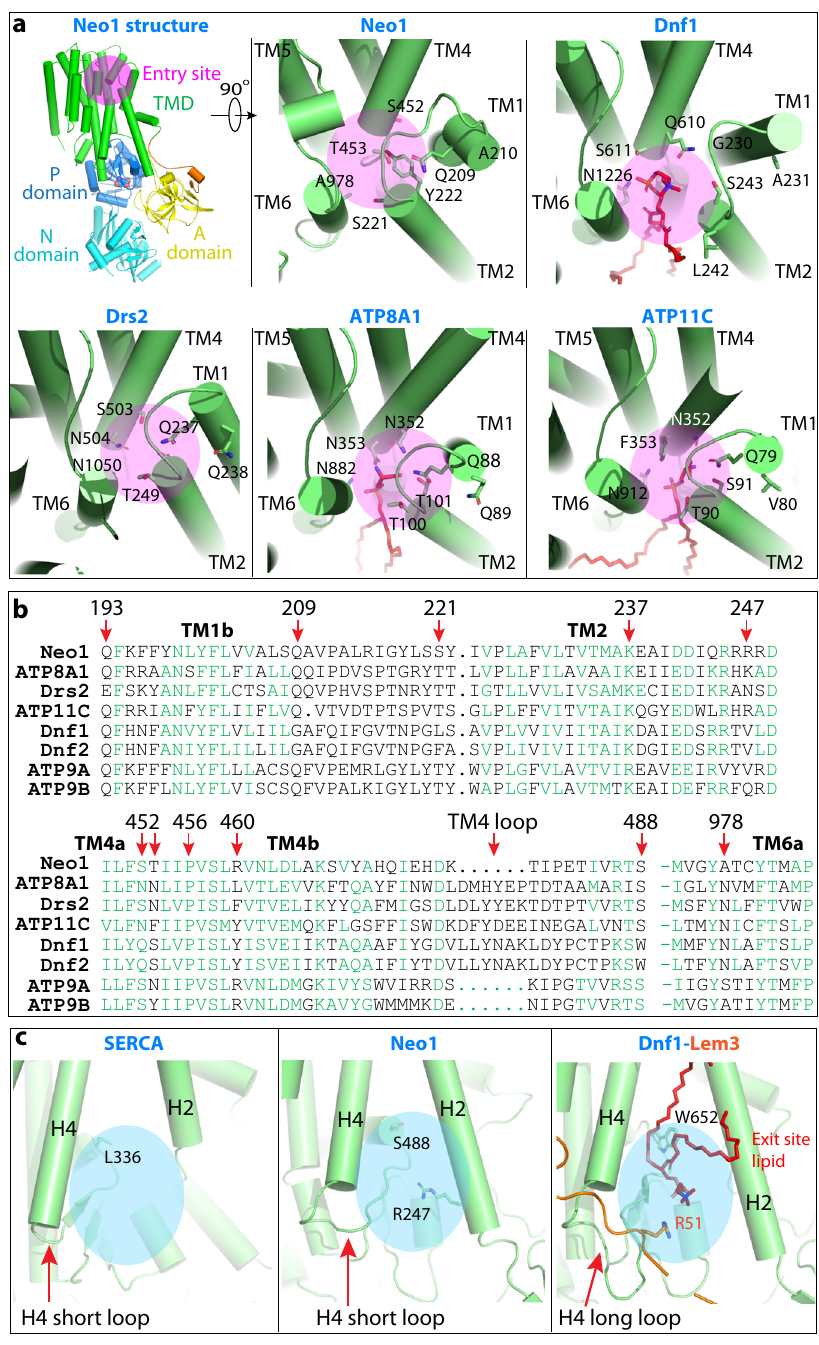
Fig. 6 Structural comparison of substrate entry and exit sites in Neo1 and other P4 ATPases. a Views of substrate entry sites in Neo1, Dnf1 (PDB ID 7KYC), Drs2 (PDB ID 6PSY), ATP8A1 (PDB ID 6K7M), and ATP11C (PDB ID 7BSV). The thermophilic Dnf1 (PDB ID 6LCP) is nearly identical to the S.c. Dnf1 and is not shown. Key residues and lipids (if present) are shown as sticks. The entry sites are highlighted by a magenta circle. b Structure-based sequence alignment of the S. cerevisiae Neo1, Dnf1, Dnf2, and Drs2, and the human ATP8A1, ATP11C, ATP9A, and ATP9B. Key residues involved in substrate lipid-binding are highlighted by red arrows. Conserved residues in well-aligned secondary structures are shown in green. The structure-based sequence alignment was performed online by ENDscript (https://espript.ibcp.fr/ESPript/ENDscript/). We modeled the ATP9A and ATP9B structures based on the Neo1 structure. c Comparison of substrate exit sites in SERCA (PDB ID 2AGV), Neo1, and Dnf1 – Lem3 (PDB ID 7KYC). The blue circles mark the substrate exit mutational studies. In one study, mutations of the TMH1 key motif QQ of Drs2 was shown to in fl uence the speci fi city for key motif GA and the TMH4 motif QS of Dnf1/Dnf2 were PS transport 49 . shown to alter their activity for PC, PE, and GlcCer, and mutation of the TMH6 key reside N1226 of Dnf1 abolished the transport of all three substrates 52 . In another study, the TMH1